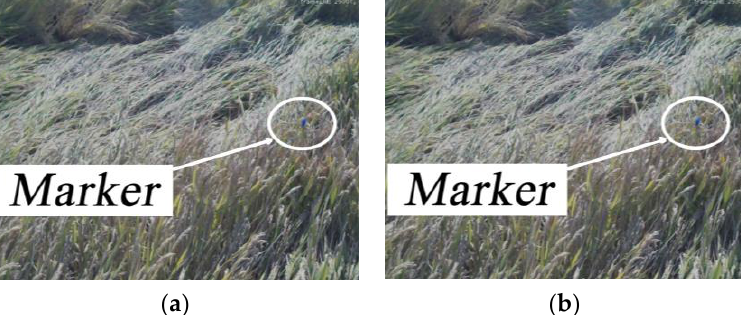
Table 3. Manual measured value of wheat height.